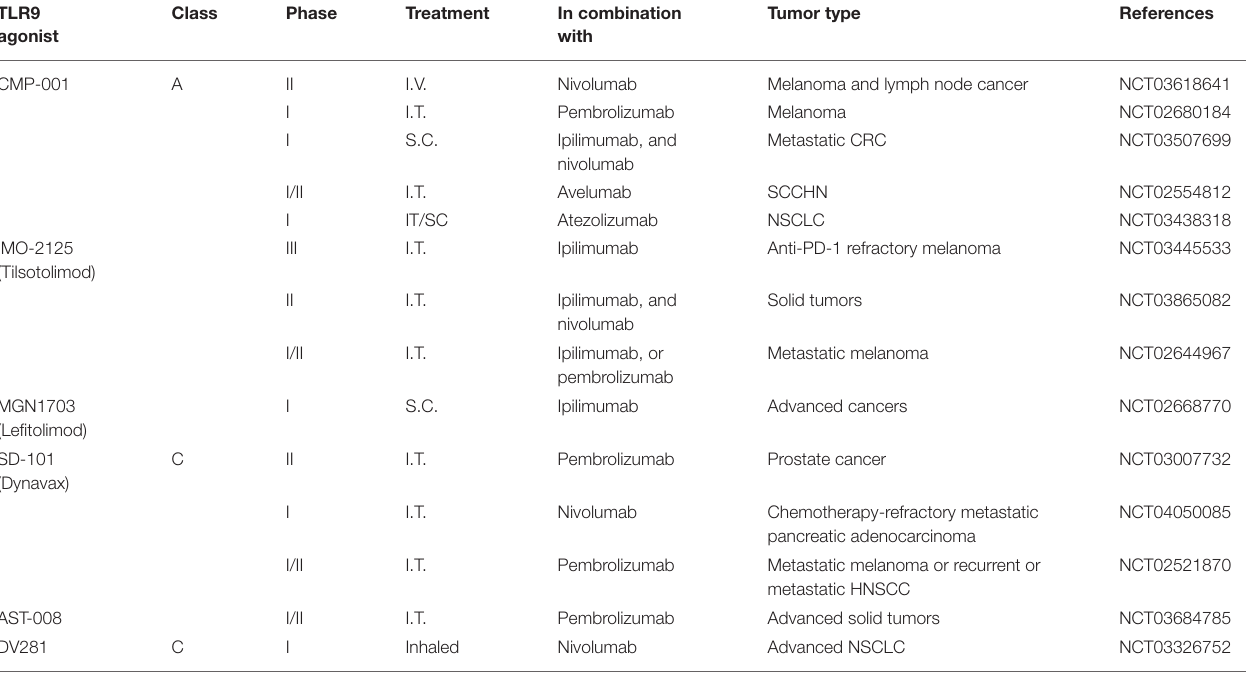
TABLE 2 | Current clinical trials of combination cancer immunotherapies using a TLR9 activation agonist and a checkpoint blockade agent. TLR9